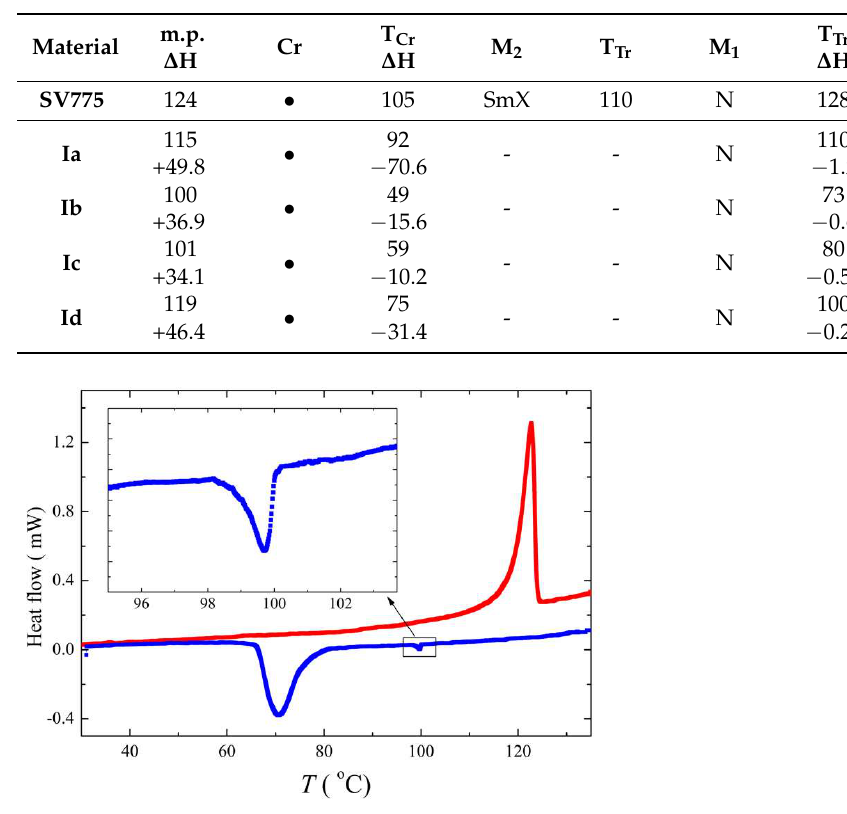
Figure 3. DSC plot of final material Id (heating—red line, cooling—blue line). The enthalpy change corresponding to the phase transition from the isotropic state to the nematic phase is shown in the inset.